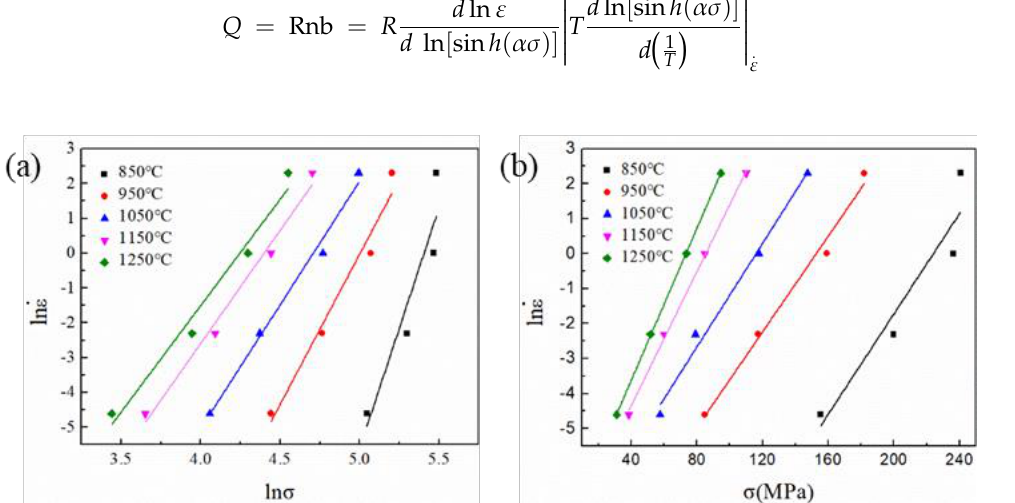
. ε . ε –ln σ , ( b ) ln – σ .